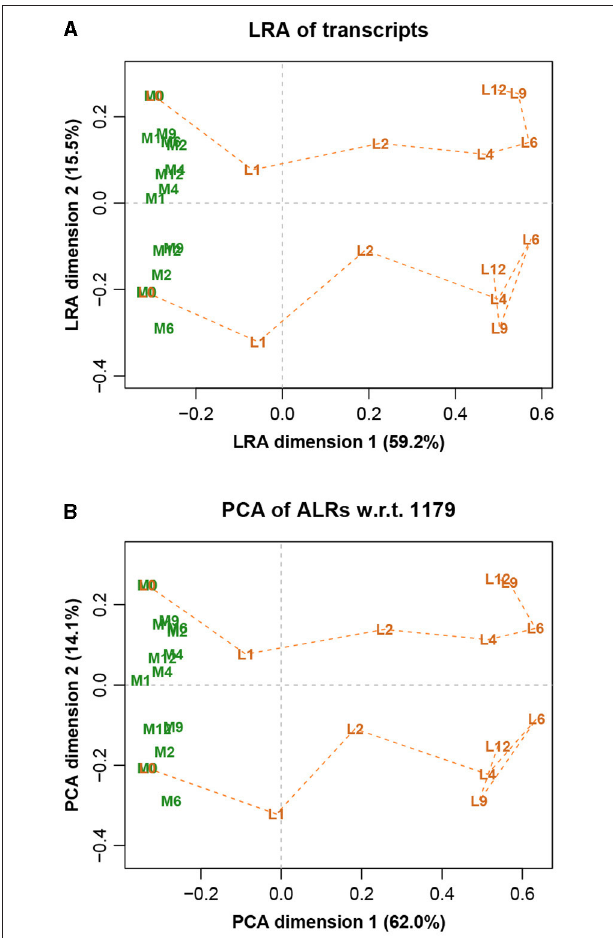
FIGURE 6 | (A) Logratio analysis of the Mice data, aiming to explain the total logratio variance. (B) Principal component analysis of the additive logratios with reference transcript number 1,179, which has a geometry almost identical to the exact logratio geometry (Procrustes correlation 0.9974). The label = prefixes M and L refer to two treatments, and the number suffixes refer to times in hours. At time 0 the M and L trajectories are at the same points.